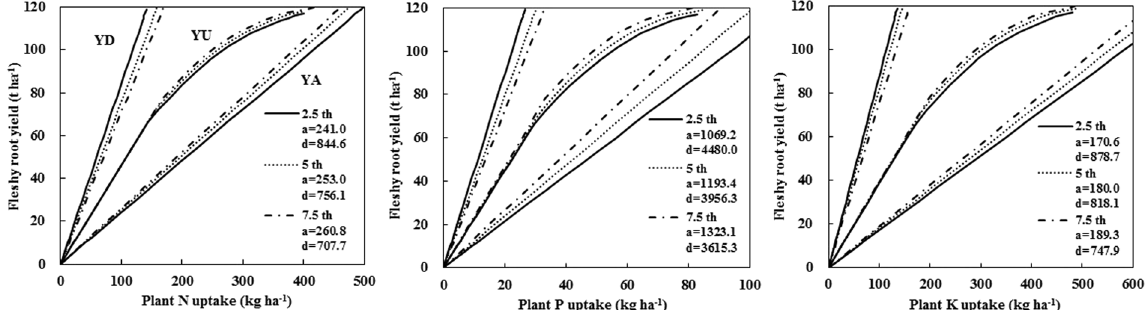
Figure 2. Radish fleshy root yield in relation to plant nutrient uptake at different ( a , d ) constants. The calculations excluded the upper and lower 2.5 (set I), 5 (set II), and 7.5 (set III) percentiles of all internal efficiency data (HI ≥ 0.4). YD, YA, and YU represent the maximum dilution, maximum accumulation, and balanced uptake of N, P, and K in plant dry matter, respectively. The potential yield was set at 120 t ha − 1 .